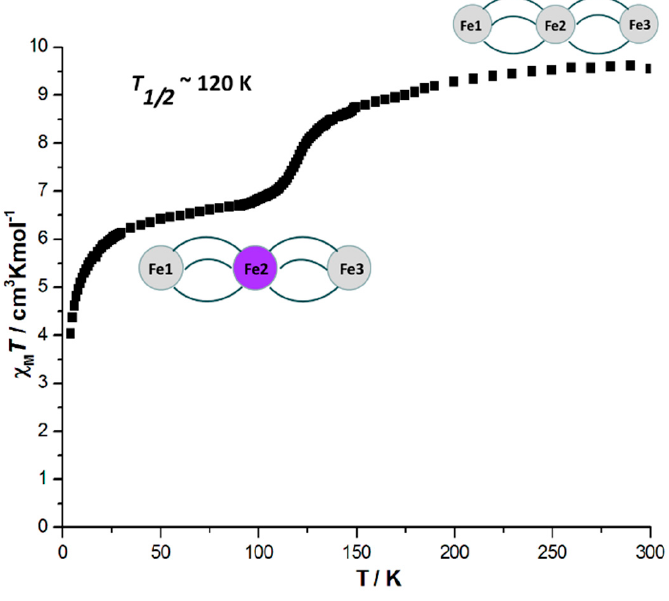
Figure 10. The temperature-dependent magnetic susceptibility ( χ M T vs. T ) for compound 2 .